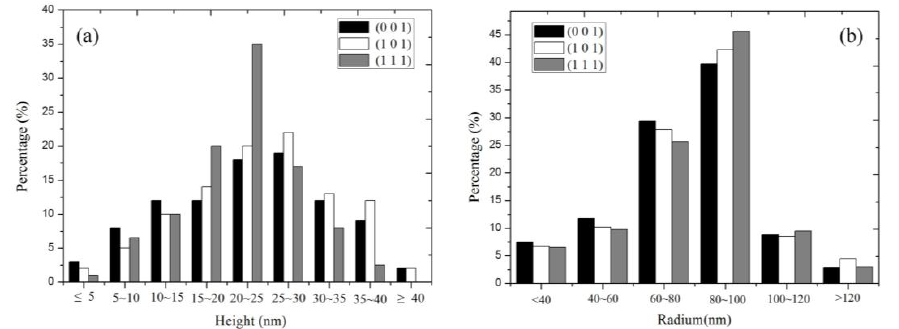
Figure 4. The distribution frequencies of ( a ) height and ( b ) radius of the nanocones formed on the grains with (0 0 1), (1 0 1) and (1 1 1) crystal orientations after post-irradiation annealing for 0.5 h.